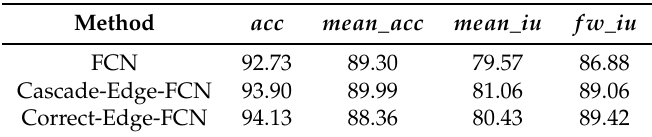
Table 7. Evaluation Results Of three methods on GID dataset. This table intuitively reflects the segmentation performance on GID dataset of the three algorithms as a whole.